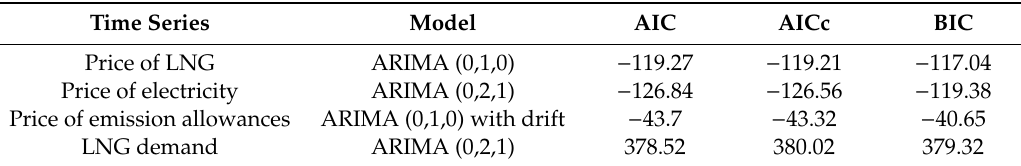
Table 4. Used ARIMA models for time series.